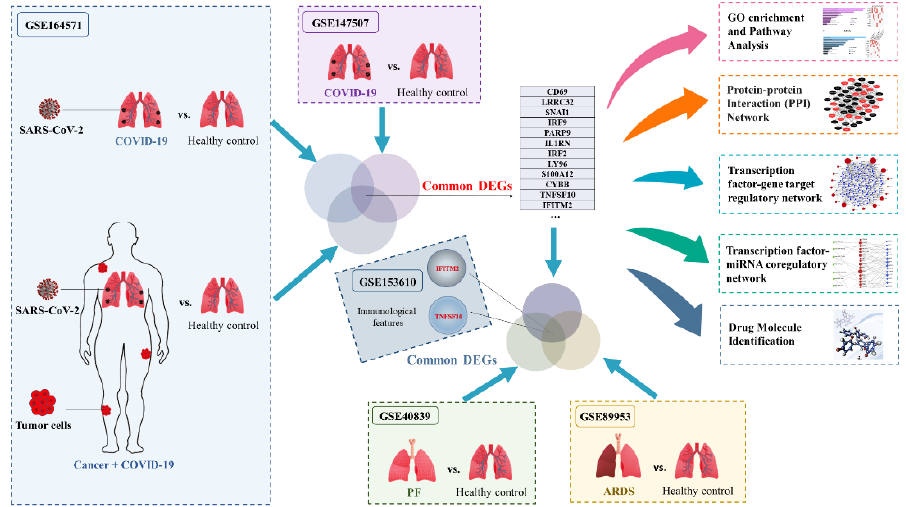
Figure 1. The workflow of current analysis. DEGs were identified between COVID-19 patients without cancer and healthy controls by using the GSE164571 and GSE147507 datasets. Then we identified the common DEGs between COVID-19 patients with and without cancer. Based on the common DEGs, a series of analyses were performed, including GO and pathway analysis, PPI network construction and hub gene extraction, transcription factor–DEG regulatory network construction, transcription factor–DEG–miRNA coregulatory network construction and drug molecule identification. In addition, the common DEGs among ARDS, PF and COVID-19 patients with and without cancer were TNFSF10 and IFITM2. The immunological features of potential biomarkers were also validated in COVID-19 patients with hematological cancer using single-cell RNA-seq analysis based on GSE153610.